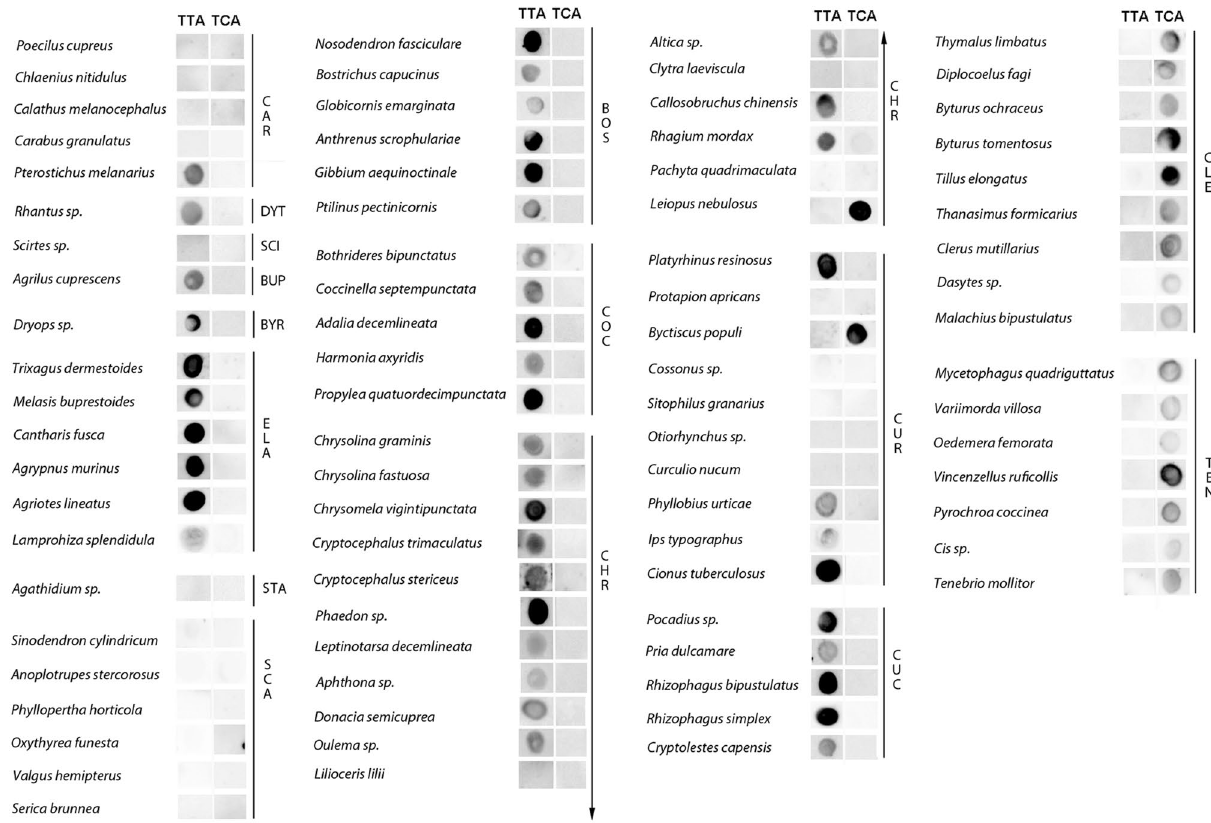
Figure 1. Dot-blot hybridizations. The presence of (TTAGG) n and (TCAGG) n sequences were examined using dot-blot hybridizations. TTA the (TTAGG)n sequence, TCA the (TCAGG)n sequence, CAR Caraboidea, DYT Dytiscoidea, SCI Scirtoidea, BUP Buprestoidea, BYR Byrrhoidea, ELA Elateroidea, STA Staphylinoidea, SCA Scarabaeoidea, BOS Bostrichoidea, COC Coccinelloidea, CHR Chrysomeloidea, CUR Curculionoidea, CUC Cucujoidea, CLE Cleroidea, TEN